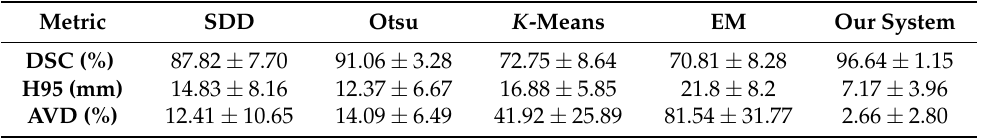
Table 2. Quantitative evaluation of our brain segmentation system compared to other segmentation approaches using DSC (%), H 95 (mm), and AVD (%). Note that SDD and EM stand for slope difference distribution based clustering and expectation maximization clustering, respectively. Results represent µ ± σ